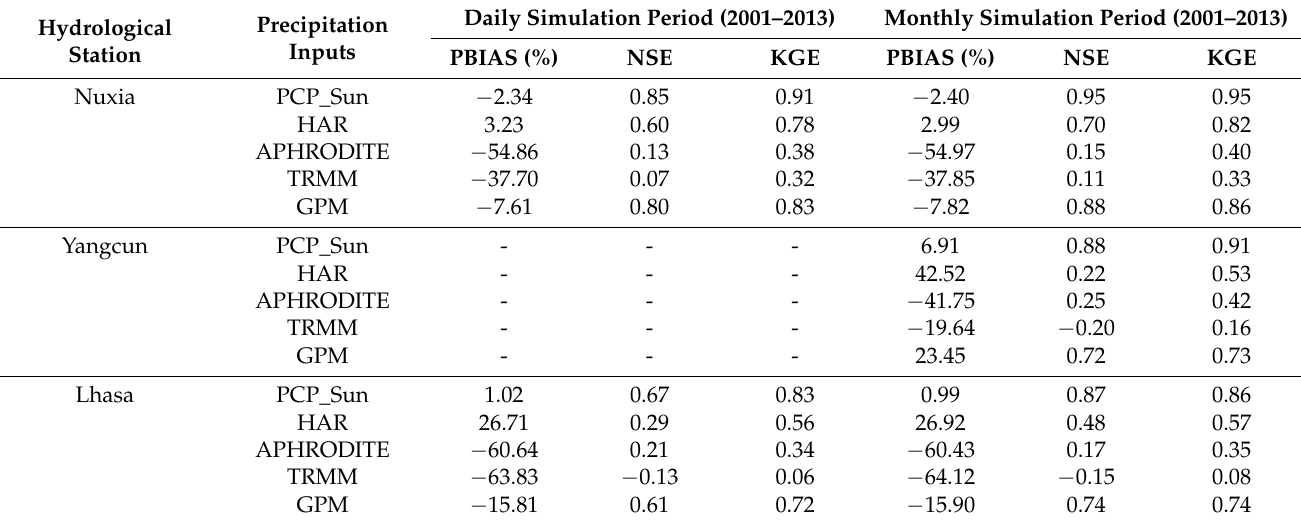
Table 7. Statistical indices of the simulated streamflow at the three hydrological stations during 2001–2013 in the